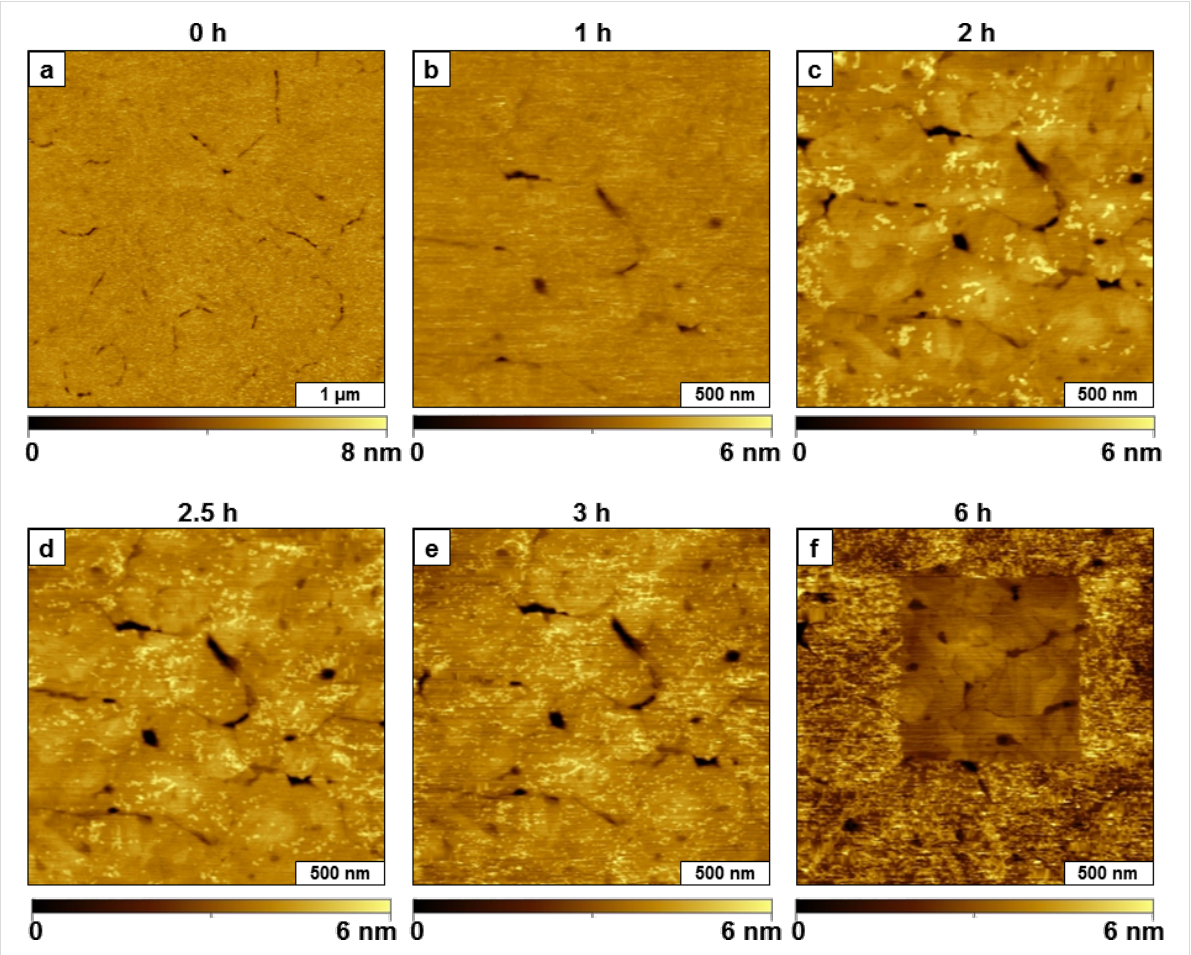
Figure 1: Solution self-assembly of TMMH on gold viewed by time-lapse AFM. Topography images (contact-mode in liquid) acquired after (a) 0 h; (b) 1 h; (c) 2 h; (d) 2.5 h; (e) 3 h; (f) 6 h after injection of TMMH solution.